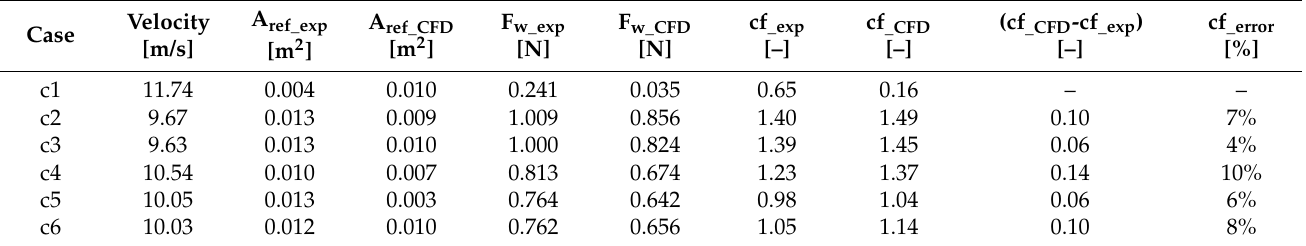
Table 1. Results of experimental and CFD